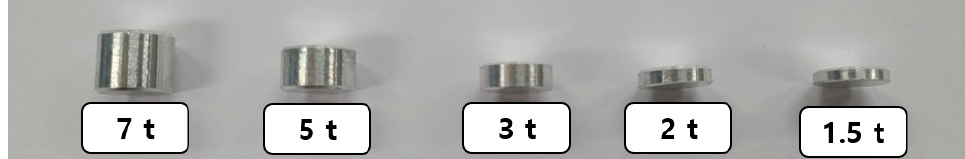
Figure 3. Al6061-T6 cylinder specimen of different thicknesses (1.5 t, 2 t, 3 t, 5 t, and 7